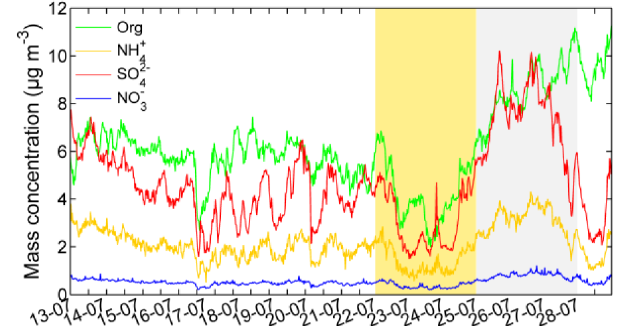
Figure 6. Mass concentrations of submicron aerosol measured at the Finokalia station from 13 to 30 of July 2013. The second period of the EF is shaded with yellow and the MSF with